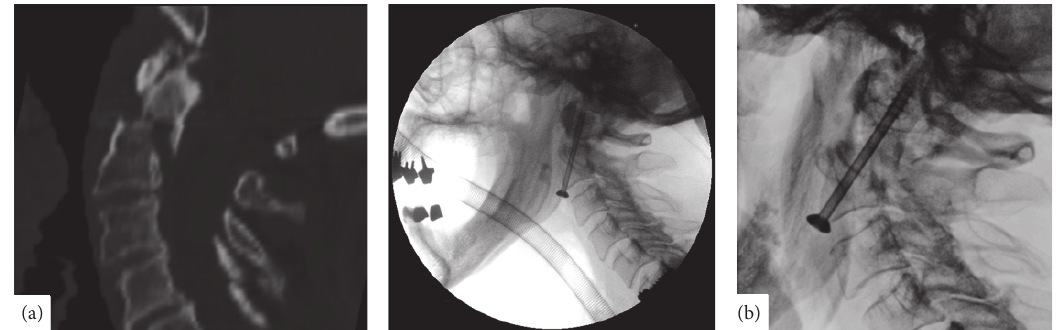
Figure 1: (a) Preoperative computed tomography (CT) of the odontoid fracture, sagittal view (left). Intraoperative view on odontoid screw placement, lateral view (right). (b) X-ray imaging disclosed a five-millimeter dorsal migration of the odontoid process three weeks after the operation, lateral view.